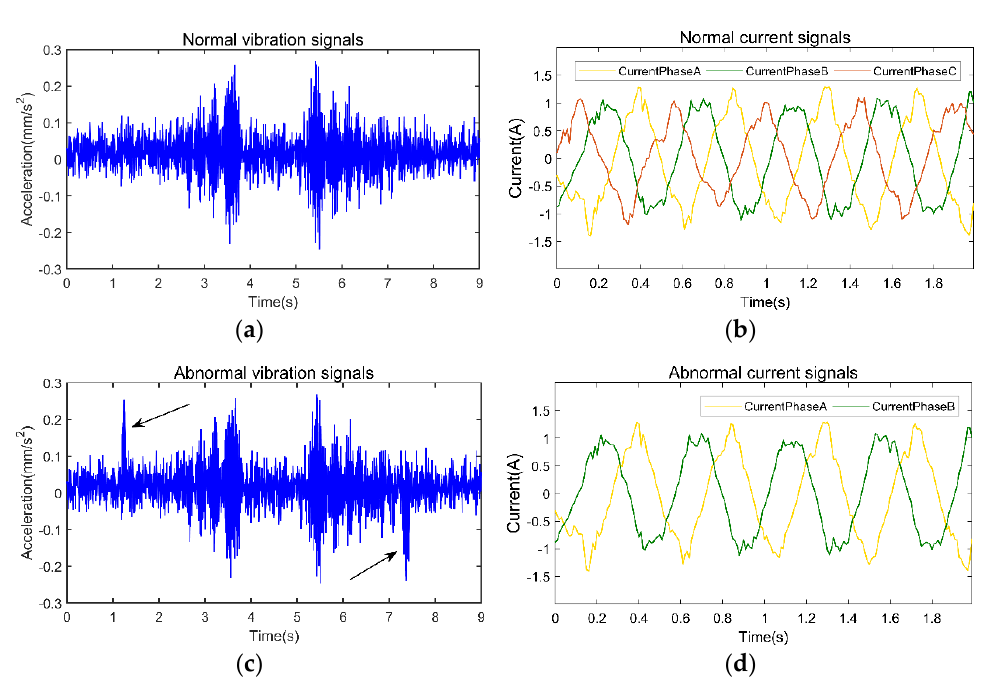
Figure 8. Normal and abnormal time domain vibration and current signals in working condition 5 under (displacement interval 420 mm): ( a ) Normal vibration signals; ( b ) Normal current signals; ( c ) Abnormal vibration signals (the arrow position is the position where the noise is introduced); ( d ) Abnormal current signals.